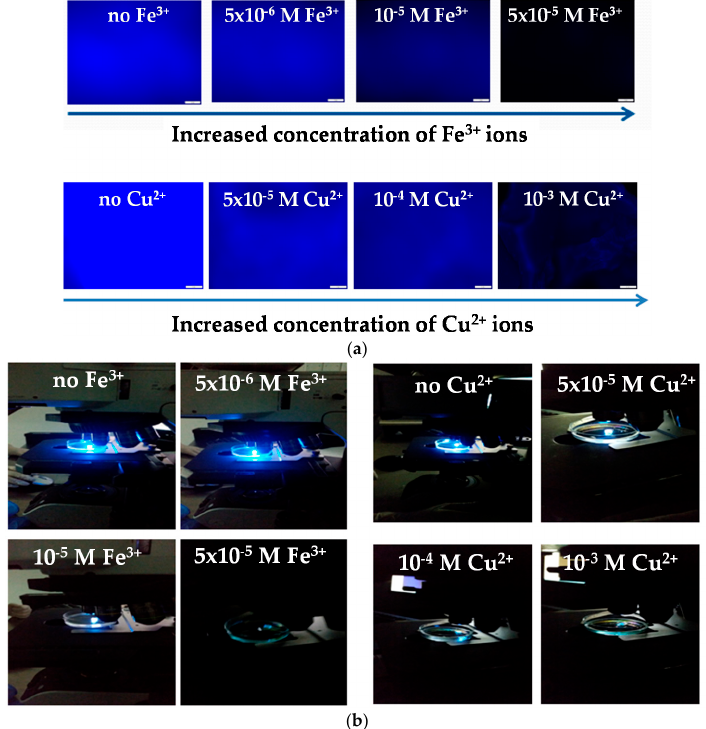
Figure 4. ( a ) Fluorescence images of the methanol-swollen BIEE/pDMAEMA/pAnMMA network immersed in pure methanol (control samples) and methanol solutions containing different Fe 3+ and Cu 2+ metal ion concentrations; ( b ) corresponding photographs. The scale bar in Figure 4a is 100 µ